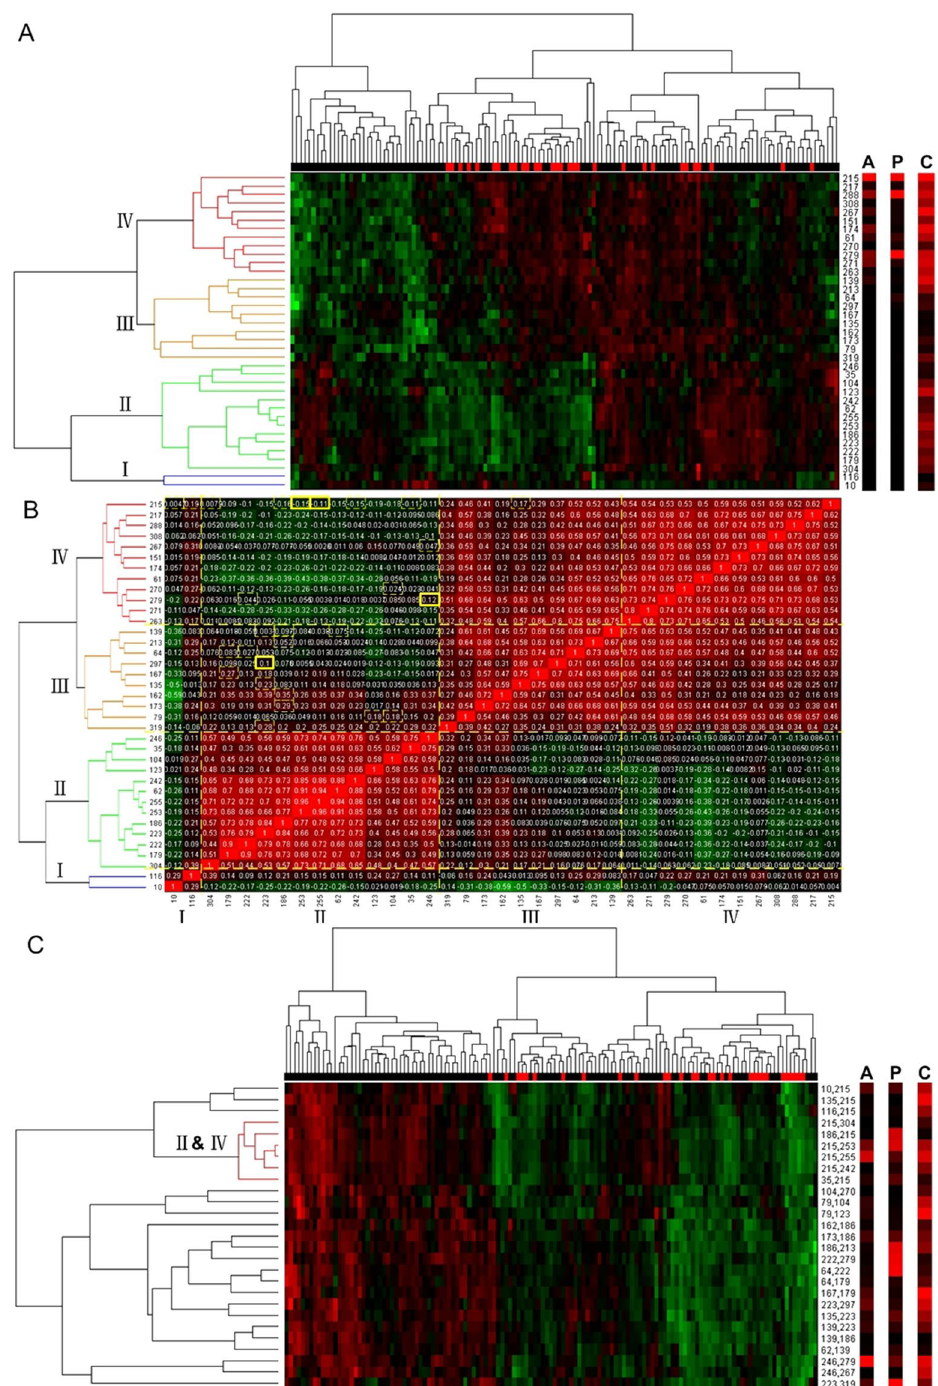
Figure 3. Correlation analyses at step A5. Row labels instead of probe names are illustrated in display convenience. The corresponding probe names can be found in Supplementary Tables S1 and S2. Bars labeled with A, P and C correspond to the overall scores of A5 accumulation, p-values and classification error rates, respectively. Panel (A) indicates a hierarchical clustering with complete linkage and centered Pearson correlation after z-score transformation of linear expression projections at step A1. Panel (B) contains the correlations reordered by the clustering results of Panel (A). Correlations of the 27 pairs chosen at step A4 are labeled with yellow boxes, of which the most significant pairs are labeled in bold. Panel (C) is also a hierarchical clustering under the same treatment as that of Panel (A), except that it is for each pair of